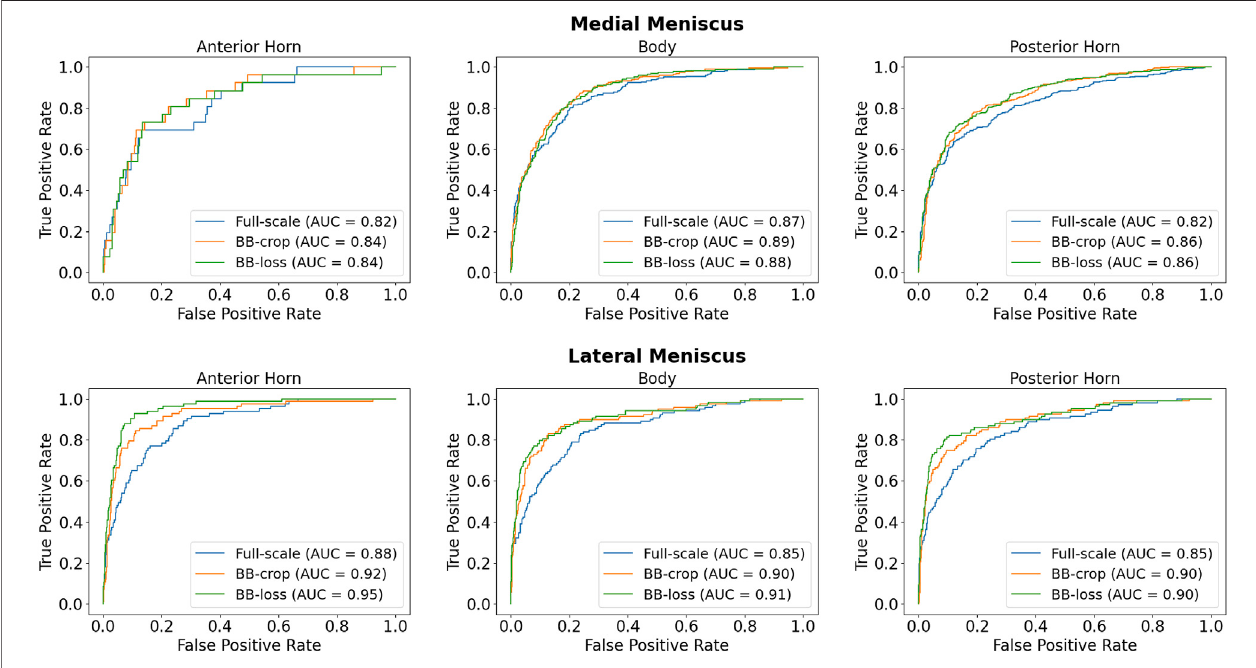
TABLE3| ROCAUCresultsformedialmenisci(MM)andlateralmenisci(LM)inIW TSE data. MM LM Method